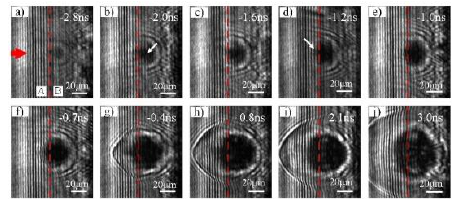
Fig. 2. The propagation of plasma and shockwave in pump laser pulse duration from -2.8 ns to 3.0 ns. Red dotted line means the interface of air side (signed as A) and bulk side (signed as B). Pump laser comes along with red arrow.